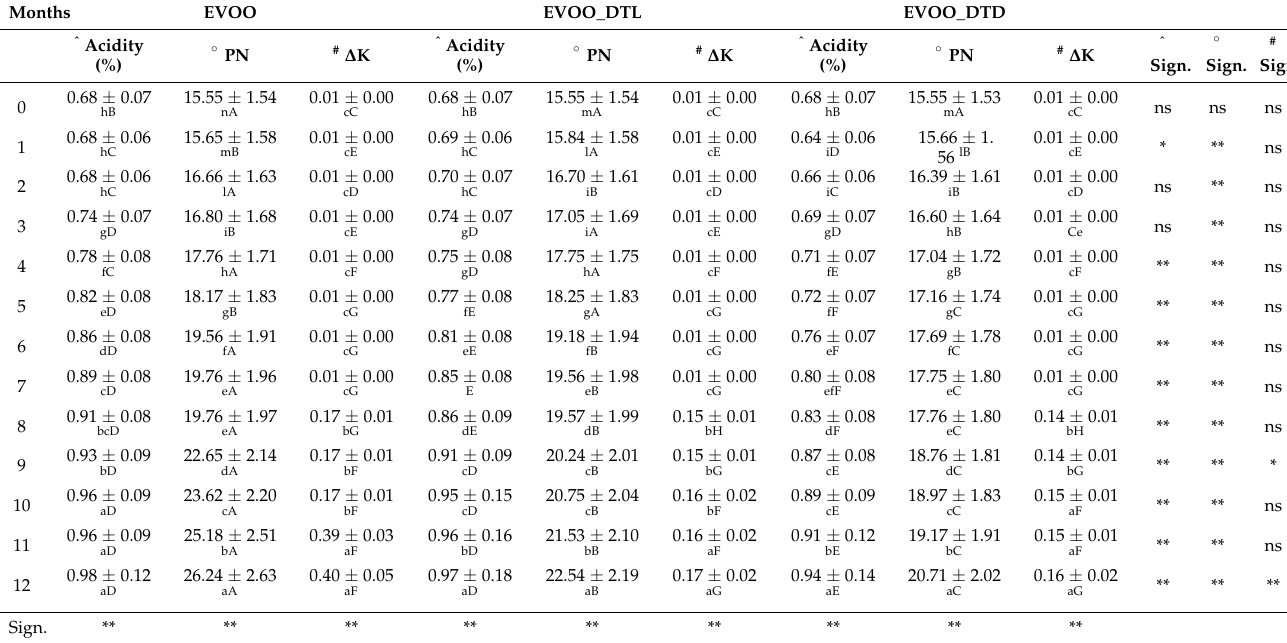
Table 2. Chemical-physical quality parameters of EVOO, EVOO_DTL, and EVOO_DTD